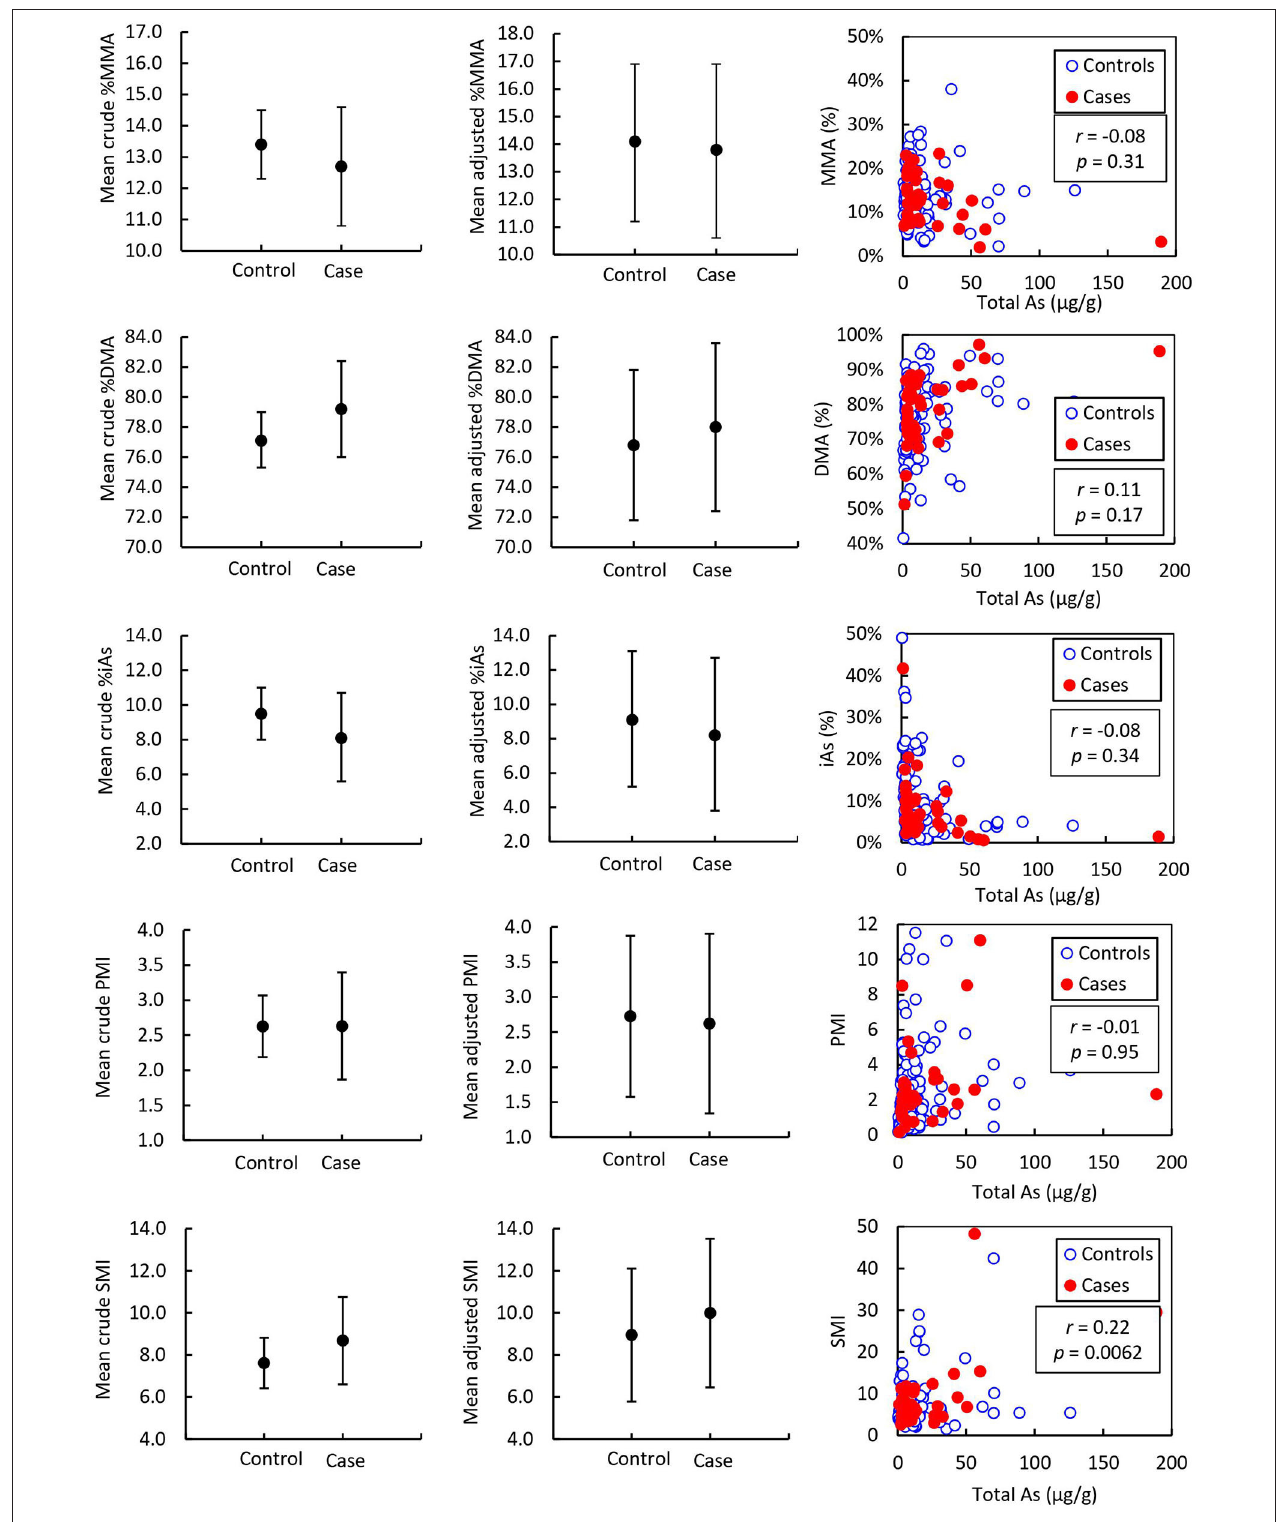
FIGURE 3 | Mean urine arsenic species of prostate cancer cases ( n = 38) and controls ( n = 114) and correlation with total arsenic adjusted to urinary creatinine concentration. Error bars indicate 95% CI. r = Pearson correlation coefficient associated with the correlation between arsenic species and total arsenic expressed as µ g As per g urinary creatinine. p = p -value associated with Pearson correlation coefficient.